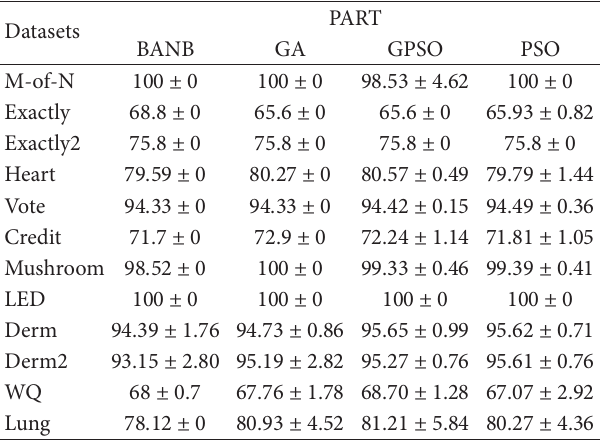
Table 5: Average classification accuracy with standard deviation for PART.